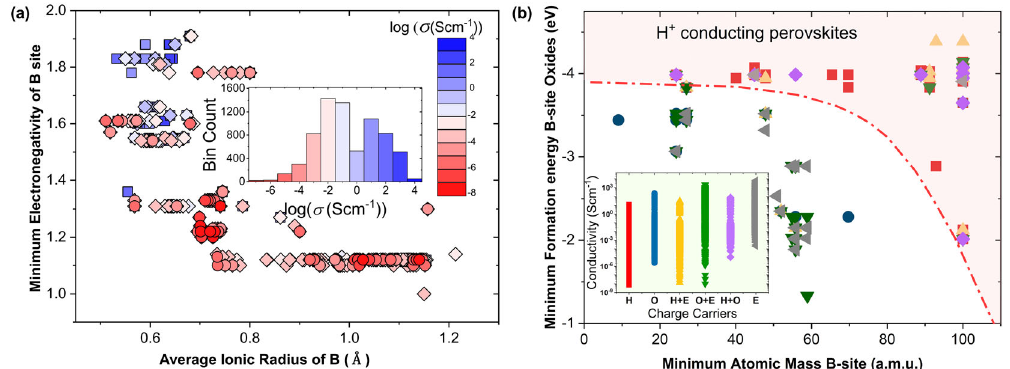
Fig. 2 Important features for the regression and classi fi cation ML models. a The conductivity of the 7230 different perovskites considered from literature with respect to the most important features from the XG-Boost regression model showing higher conductivities for higher minimum electronegativity of B-site ions and lower average B-site ion size. b The type of charge carrier (proton, oxygen, mixed protonic/ electronic, mixed oxide/electronic, mixed protonic/oxide, and electronic conductors) with respect to the most important features from the XG- Boost classi fi er model, showing that the lower B size atomic mass and higher minimum formation energy of B-site oxides regions are mostly electronic or mixed oxide/electronic conductors. All the proton-conducting perovskites (which are of interest for low temperature conductivities) have relatively high B-site atomic mass or lower formation energy of B-site oxide. The range of conductivities for each charge carrier is shown in the